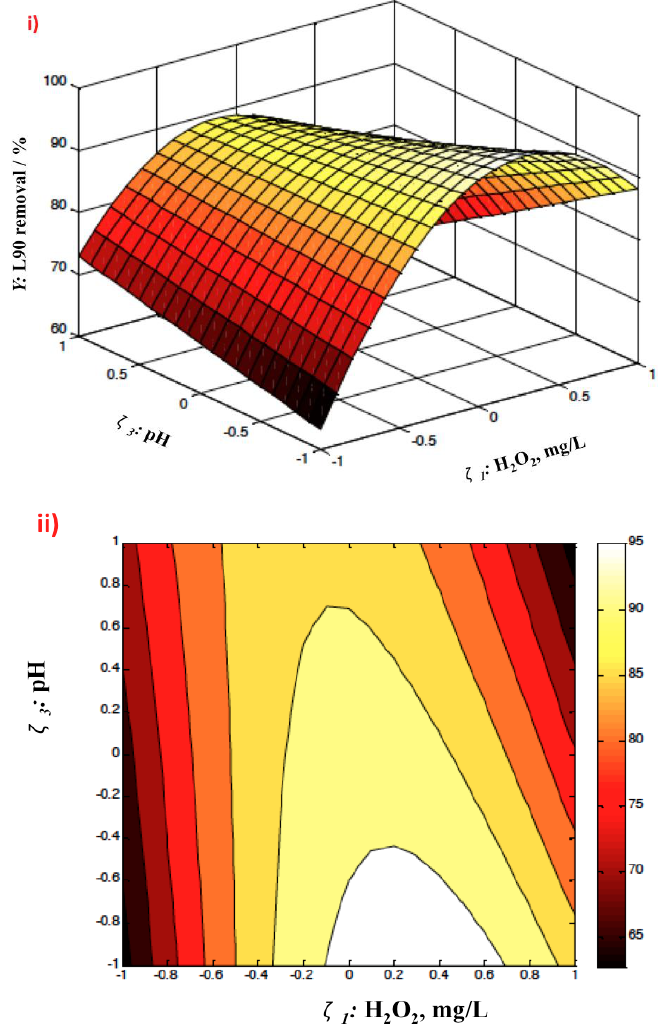
Figure 9. Factorial model design’s optimal results: ( i ) 3-D surface plot and ( ii ) 2-D contour plot of the ( Y ) response and the interacting effect of H 2 O 2 and pH.